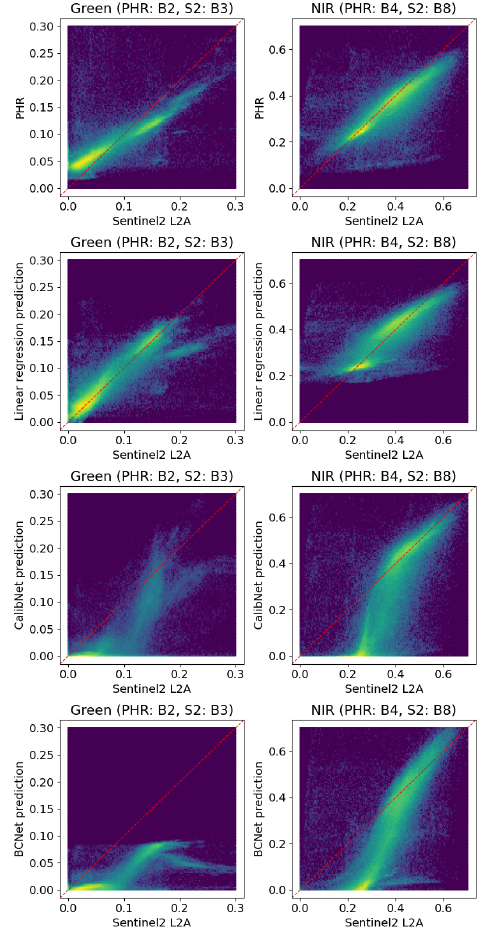
Figure 15. Scatter plot between Pleiades and Sentinel-2 surface reflectance for the Bretagne2 dataset, where the Pleiades image is contaminated by unmasked clouds, for all methods for Green and NIR bands.